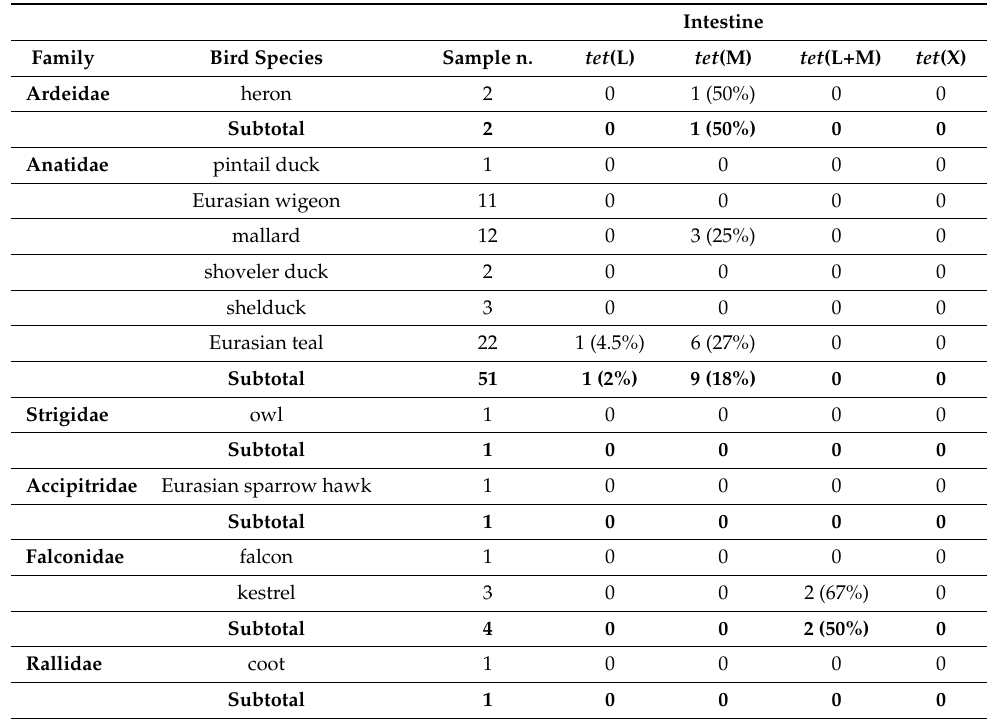
Table 4. Tetracycline resistance genes detected in the intestines of wild